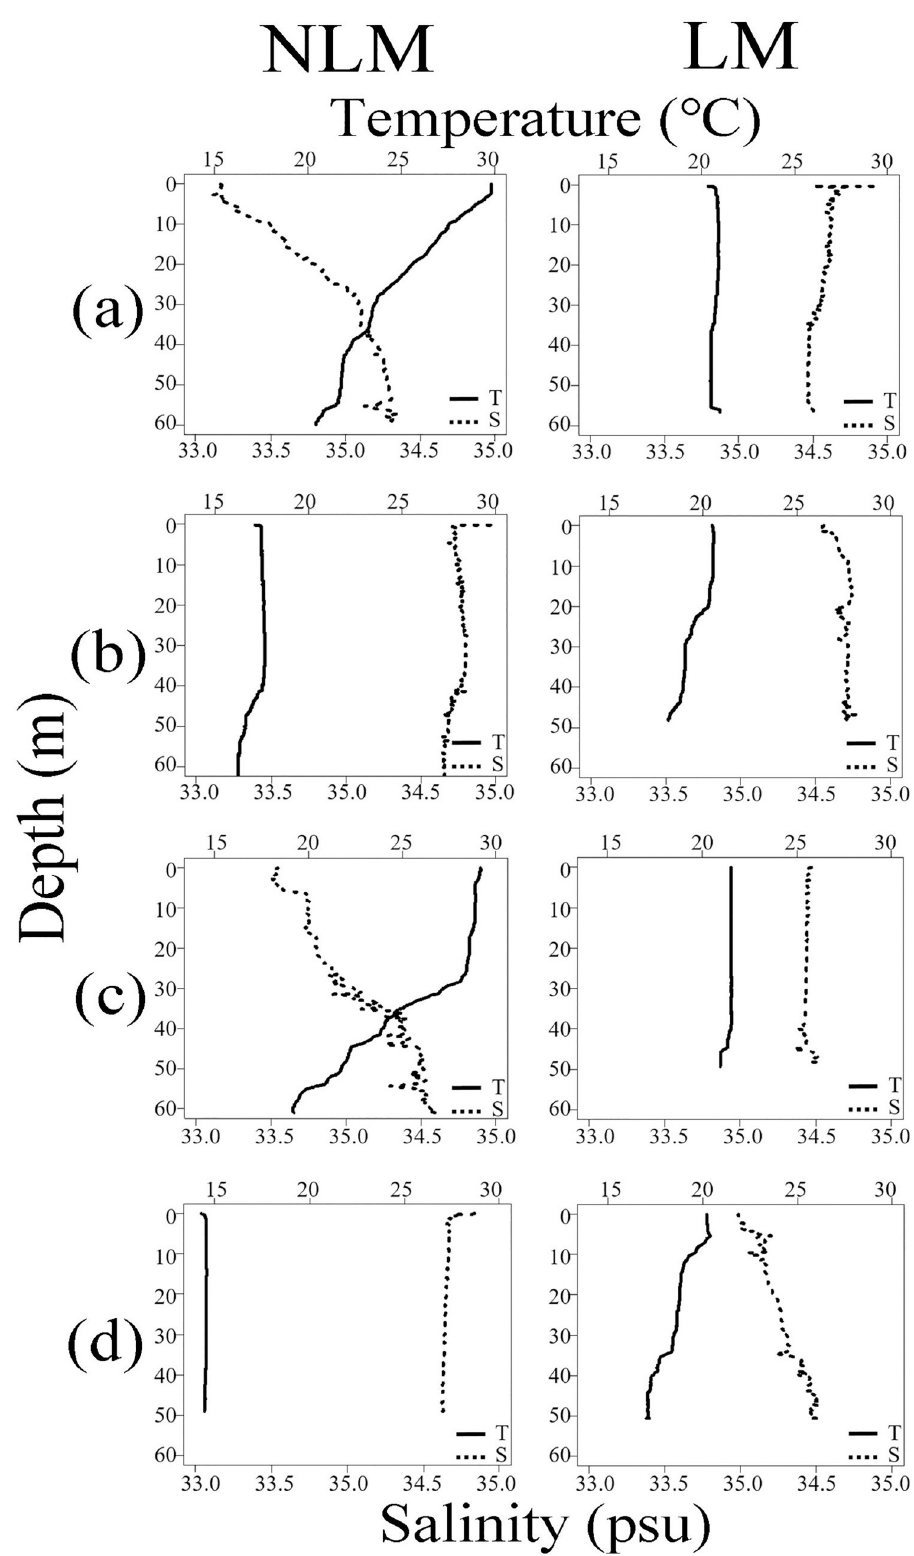
Fig 6. Seasonal vertical distribution of temperature and salinity around set net. The solid and the dotted lines indicate temperature and salinity, respectively (a: Summer, b: Autumn, c: Winter, d: Spring). https://doi.org/10.1371/journal.pone.0260629.g006 PLOS ONE | https://doi.org/10.1371/journal.pone.0260629 November30,